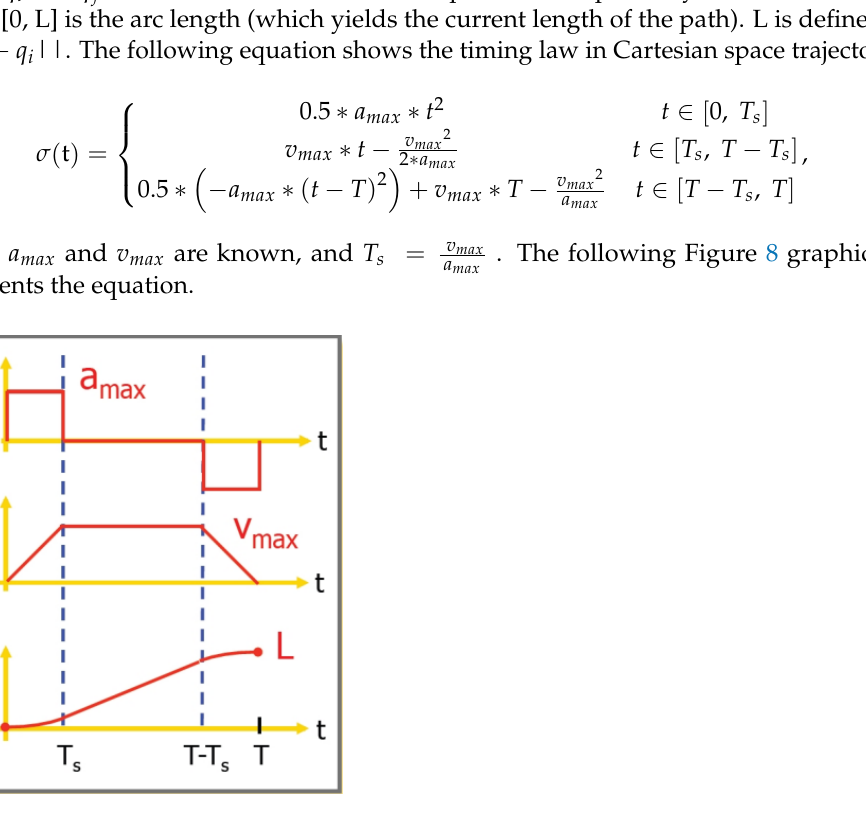
Figure 8. Timing law in Cartesian space trajectory.